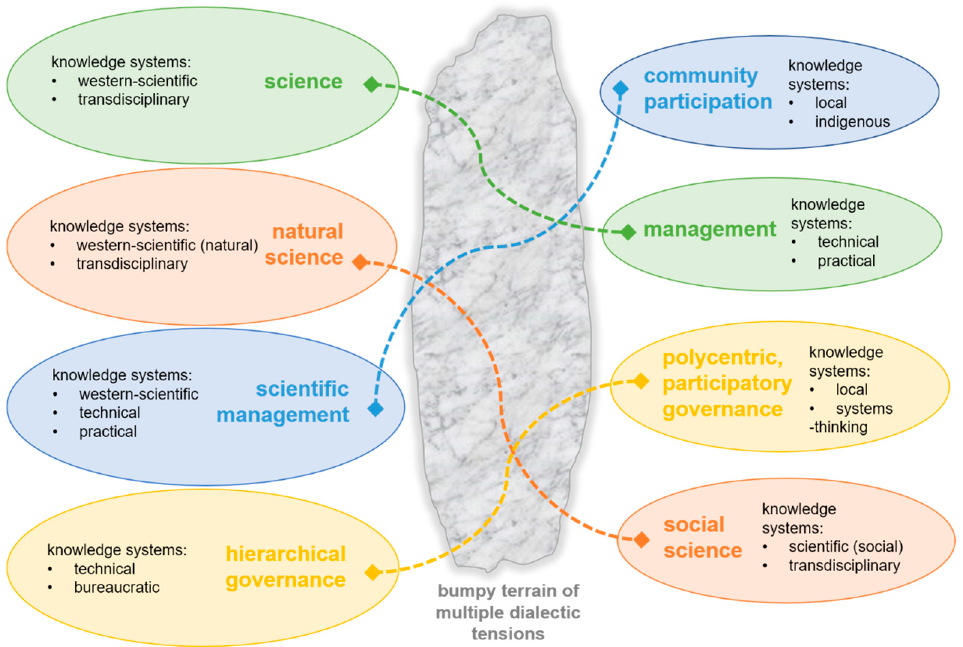
Figure 5. A bumpy terrain of multiple, interconnected dialectic tensions to be navigated by participants in the Tsitsa Project (grey area in the centre). This terrain is characterized by intersecting linkages between actors operating from different domains of practice informed by different knowledge systems (ovals on the left and right-hand side of the diagram).